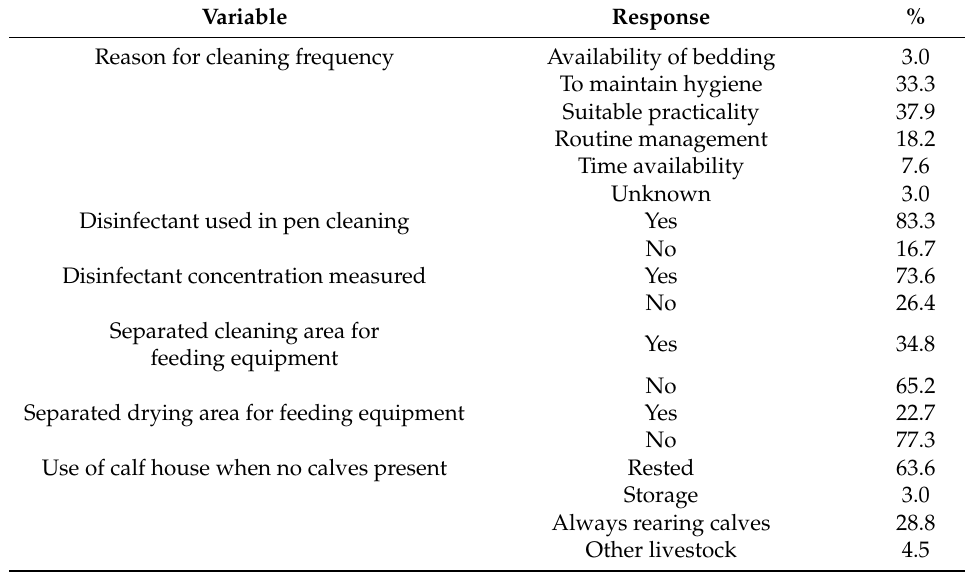
Table 4. Hygiene management of pre-weaned